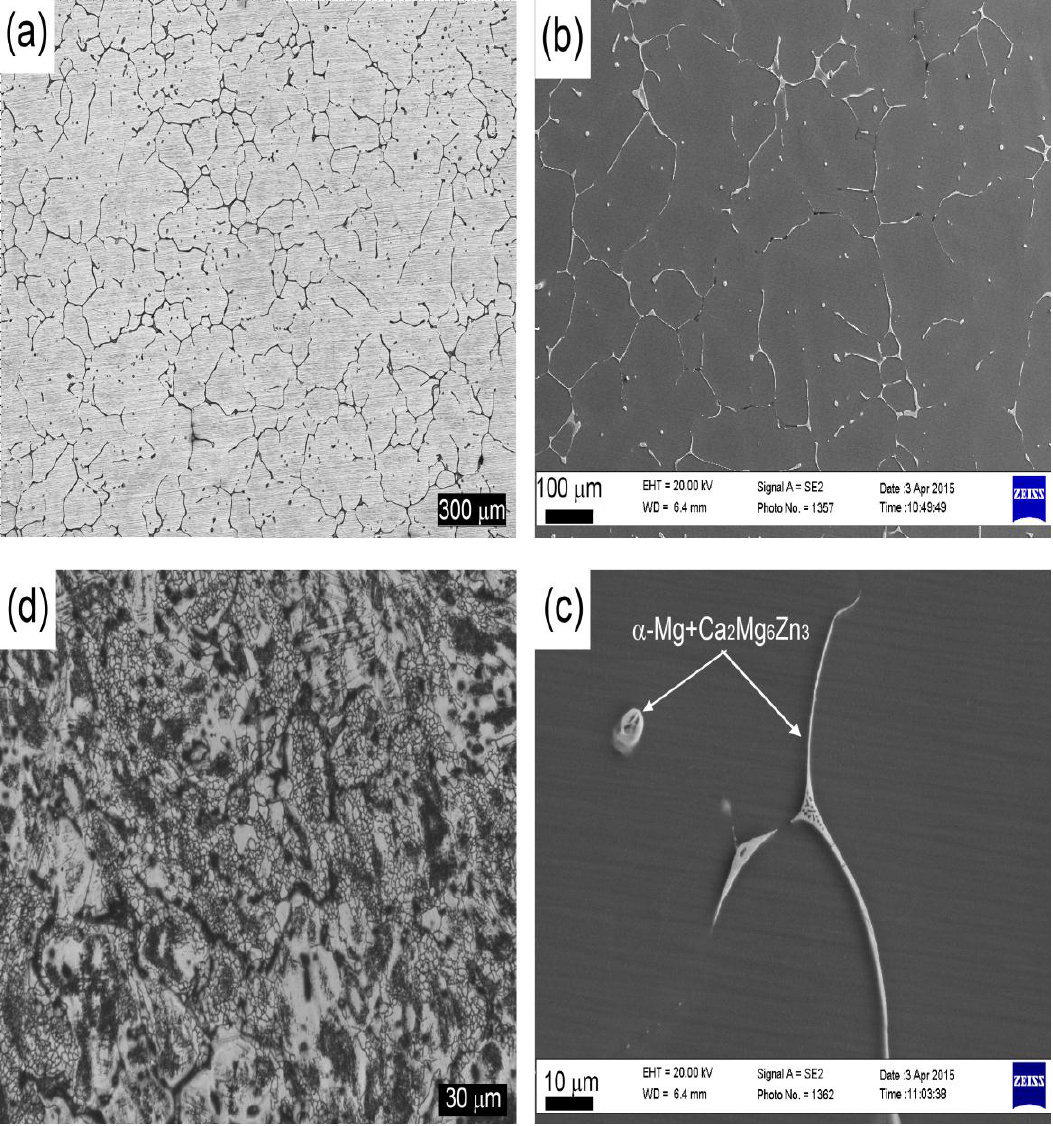
Figure 1. Optical ( a ); and SEM ( b ); and ( c ) micrographs showing a phase structure of the as-cast ZX40 Mg-4Zn-0.16Ca alloy; ( d ) the same alloy after Equal Channel Angular Pressing (ECAP).